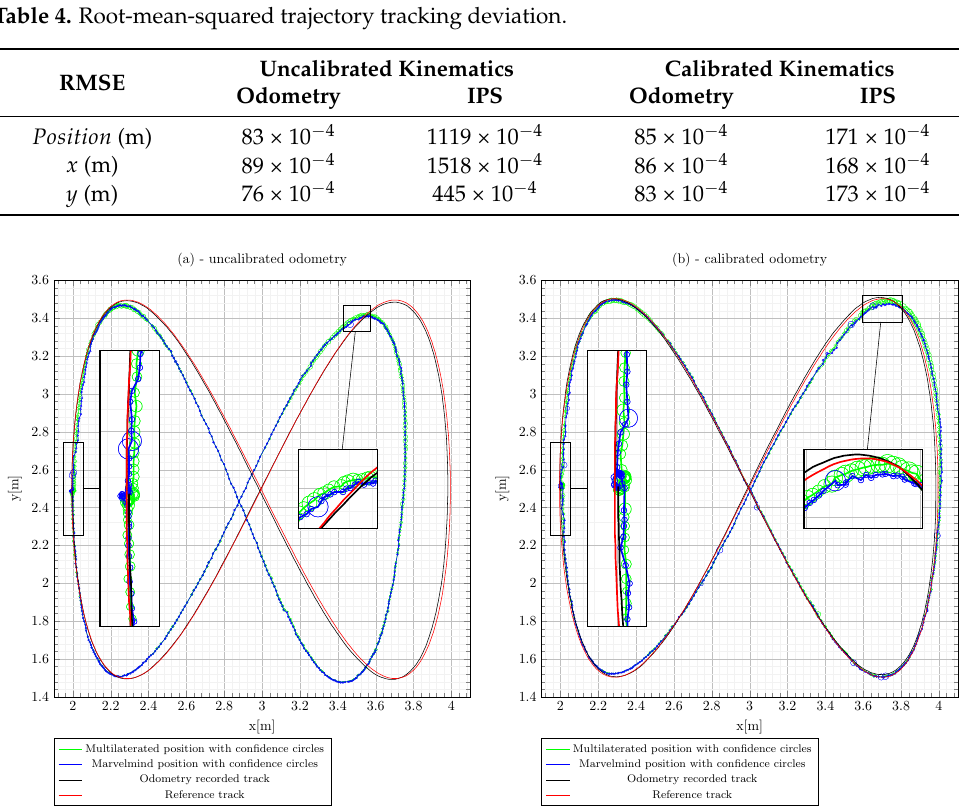
Multilaterated position with confidence circles Marvelmind position with confidence circles Odometry recorded track Reference track